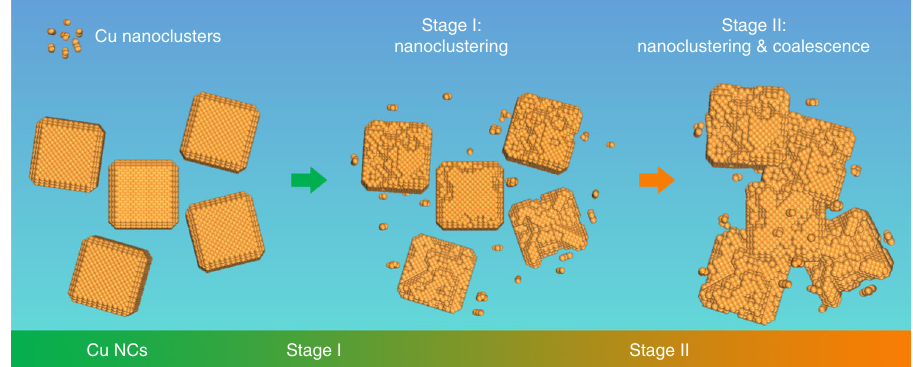
Fig. 6 Overview of the degradation mechanism of CuNCs during CO 2 RR. Schematic representation of the degradation mechanism that includes nanoclustering (Stage I) followed by a coalescence at a later stage (Stage II)